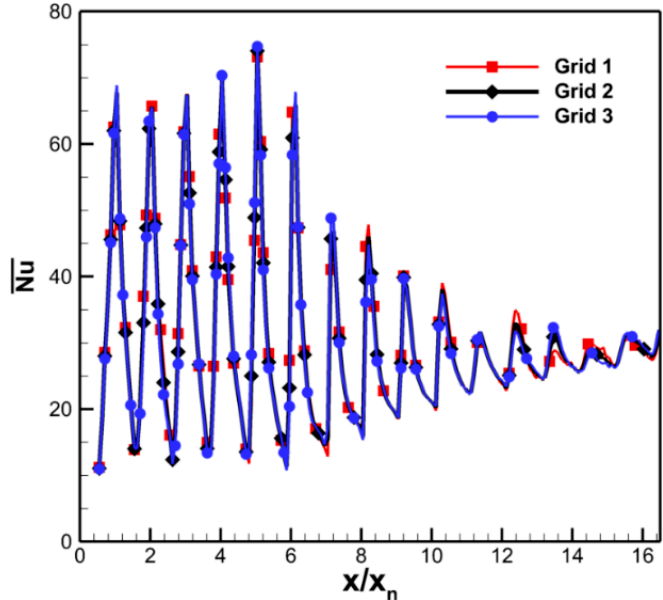
Figure 8. Grid sensitivity analysis.